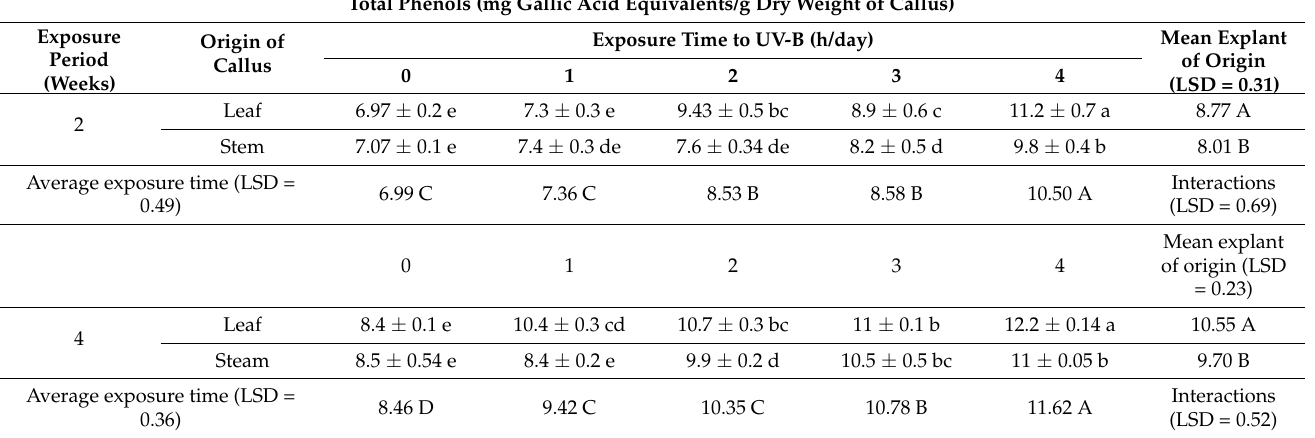
Table 4. Effect of exposure time to UV-B radiation and source explant on total phenol concentration in callus culture.